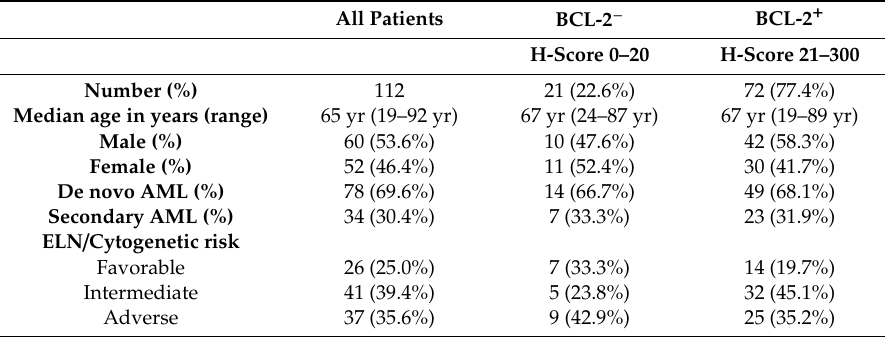
Table 1. Baseline characteristics of the BCL-2 − and BCL-2 + AML